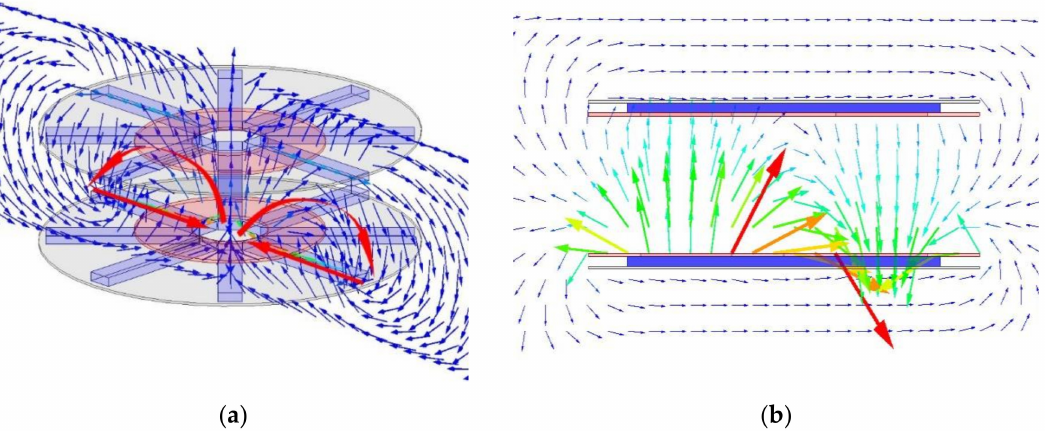
Figure 12. Schematic diagram of coupling magnetic field direction: ( a ) single-sided single-winding structure; ( b ) single-sided multi-winding structure.